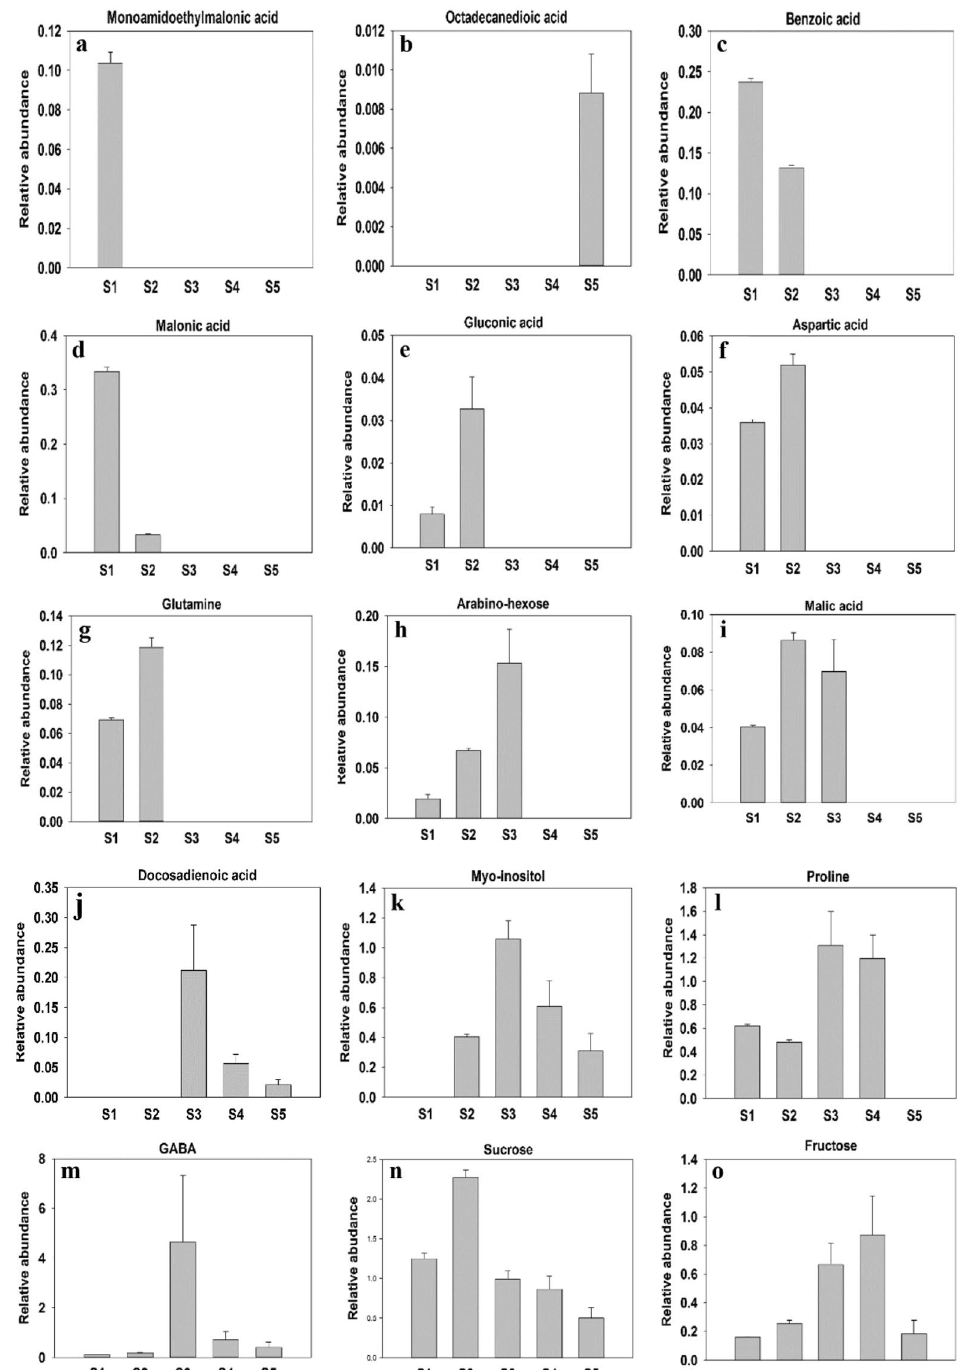
Figure 3. Graphical representation of metabolites identified from the PLS-DA variable importance projection (VIP) showing major differences in accumulation in Saffron corm at five different developmental stages